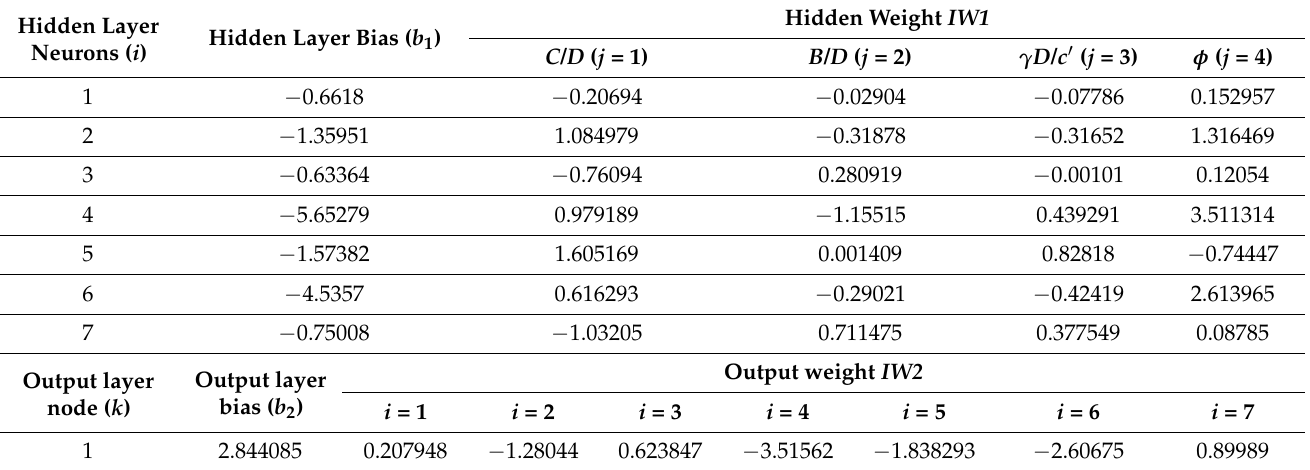
Table 4. Neural network constants of the optimal model for stability prediction of shallow elliptical tunnels in cohesive-frictional